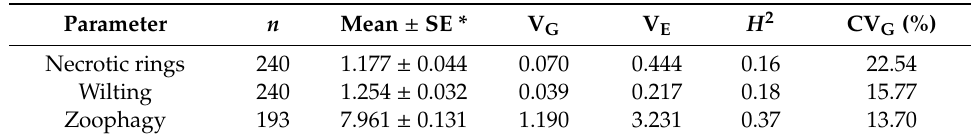
Table 2. Estimates of the means and standard errors (SE), genetic variation (V G ), environmental variation (V E ), broad-sense heritability ( H 2 ), and coefficient of genetic variation (CV G ) for infliction of necrotic rings and wilting on tomato leaves, and zoophagy (i.e., consumption of E. kuehniella eggs in 24 h) by N. tenuis . Estimates are based on the squared-root-transformed data for necrotic rings and zoophagy, and arcsine-transformed data for wilting.